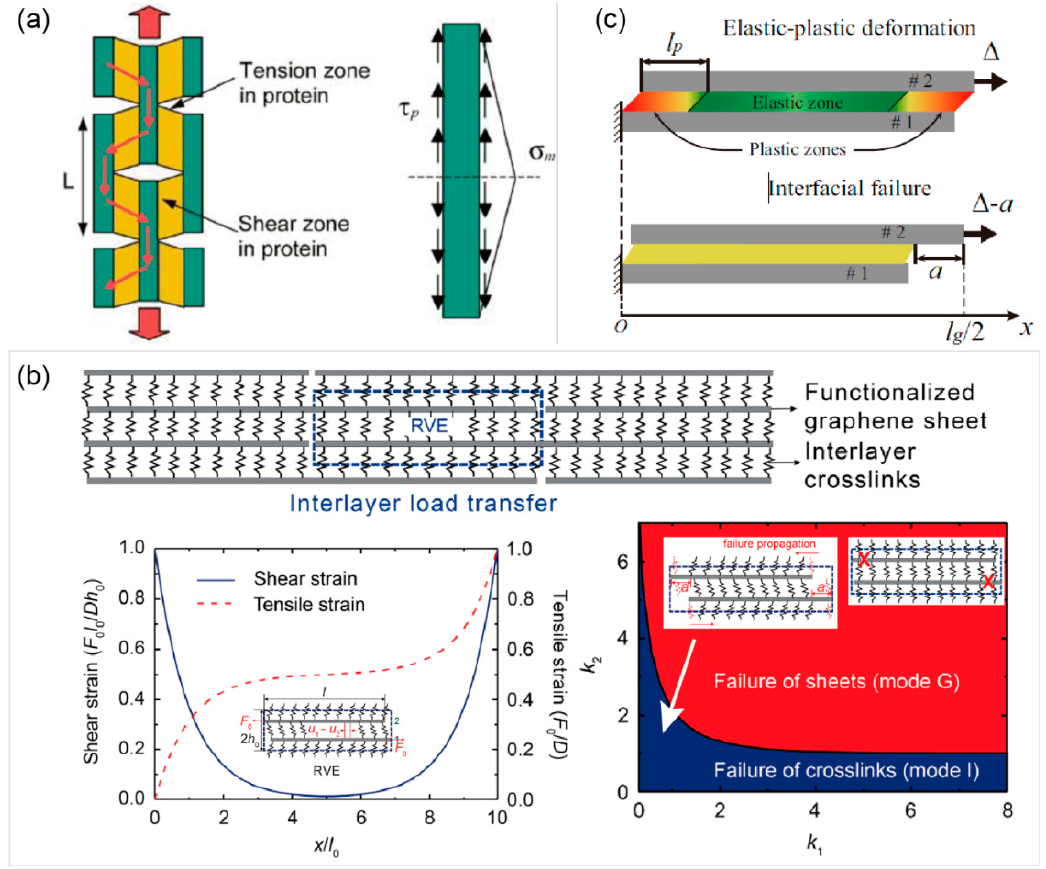
Figure 3. Tension–shear models for the nacre ‐ like structure. ( a ) Tension–shear chain (TSC) model. The mineral tablets were assumed to be rigid, and the shear deformation of protein was the same everywhere. Reprinted with permission from [74]. ( b ) Deformable tension ‐ shear (DTS) model. Two failure modes were distinguished, namely fracture of sheets (mode G) and failure of crosslinks (mode I). Adapted and reprinted with permission from [22]. ( c ) Nonlinear tension–shear model. The interlayer interactions are elastic perfectly plastic. Reprinted with permission from [23].